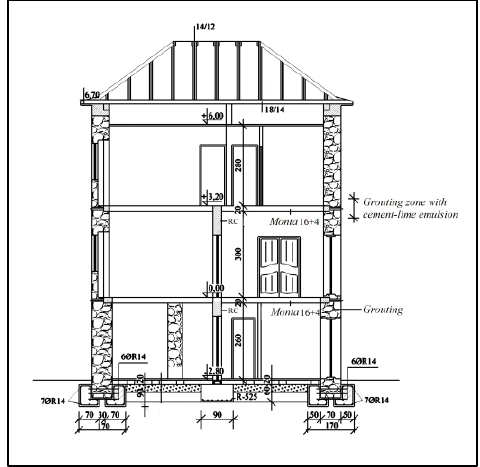
Figure 35. Vertical cross-section of the building. Figure 35. Plan of floor attic reinforcing.